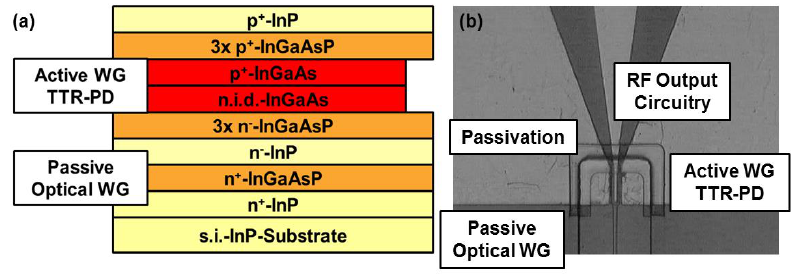
Figure 5. ( a ) Schematic cross section of the TTR-PD layer structure with a monolithically-integrated passive optical waveguide (WG) and ( b ) scanning electron microscope (SEM) photograph of the fabricated WG TTR-PD